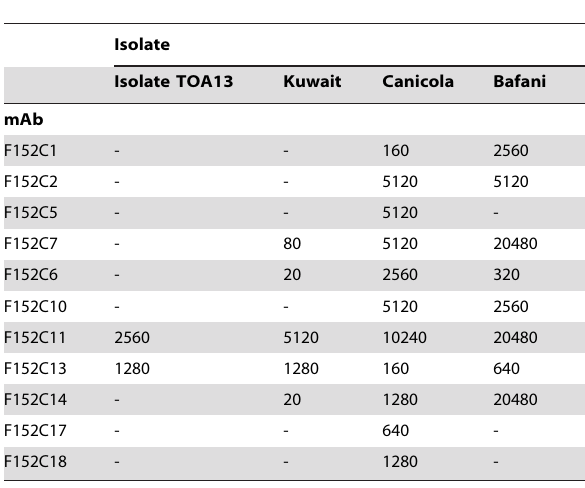
Numbers indicate reciprocal titers. TOA13 is shown as a typical example of all 10 isolates.